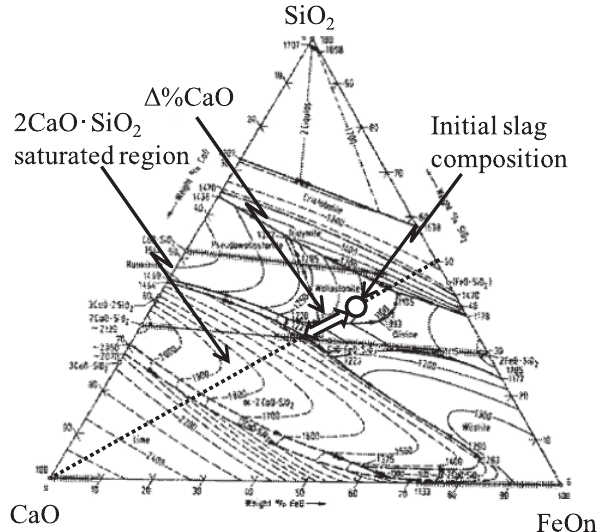
Fig. 1: Phase diagram of FeO-CaO-SiO 2 system